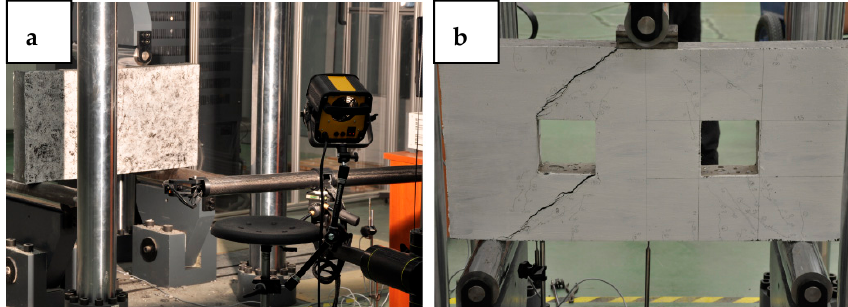
Figure 7. Test station of deep beams: ( a ) without openings DB and ( b ) with openings DBO.